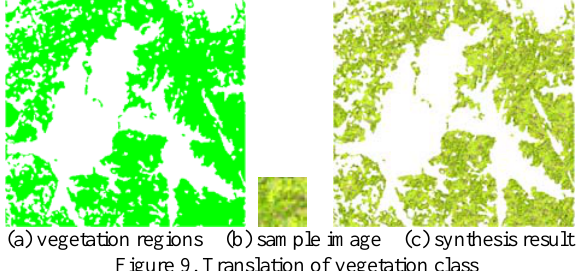
Figure 9. Translation of vegetation class